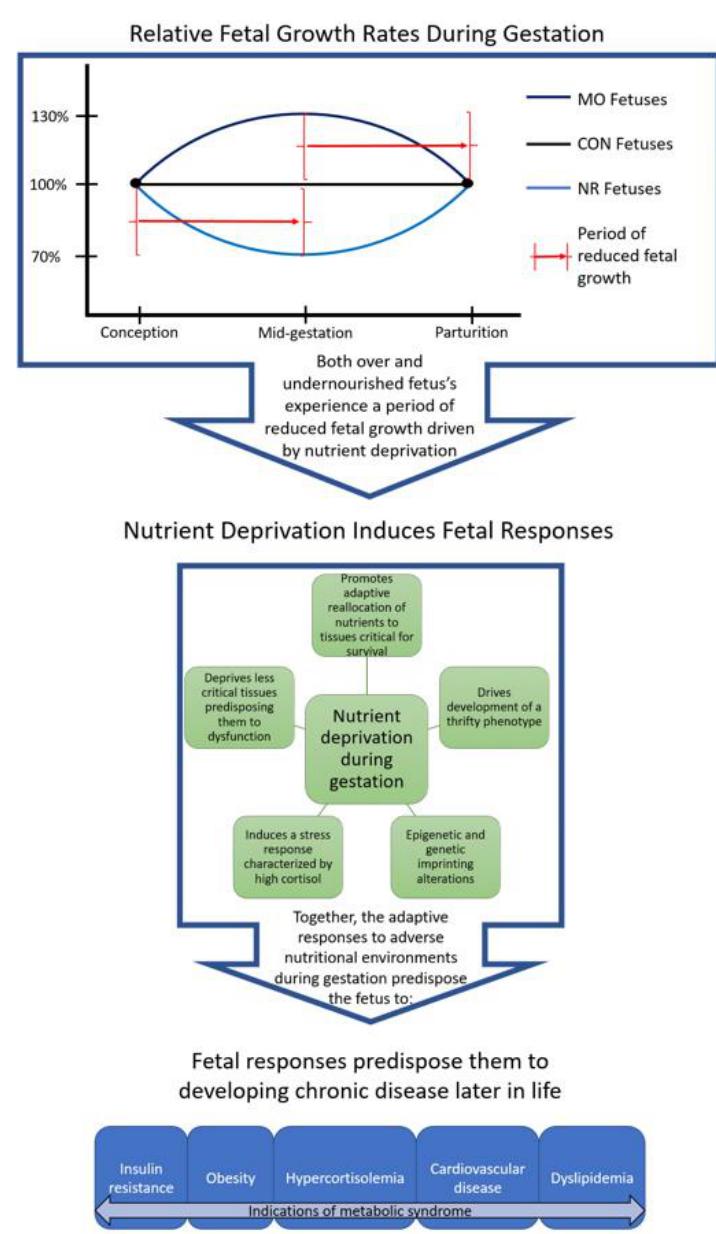
Figure 2. Summary diagram of the mechanisms behind similar fetal outcomes from maternal obesity (MO) and nutrient restriction (NR) relative to controls (CON). In both circumstances, there is a period of fetal growth restriction resulting from nutrient deprivation. Nutrient deprivation of tissues and organs that are not immediately critical for survival, but still play important metabolic roles, predisposes the fetus to developing metabolic derangements in postnatal life. Predisposition to metabolic disease can persist through multiple generations but is often latent until the individual is exposed to a metabolic stress